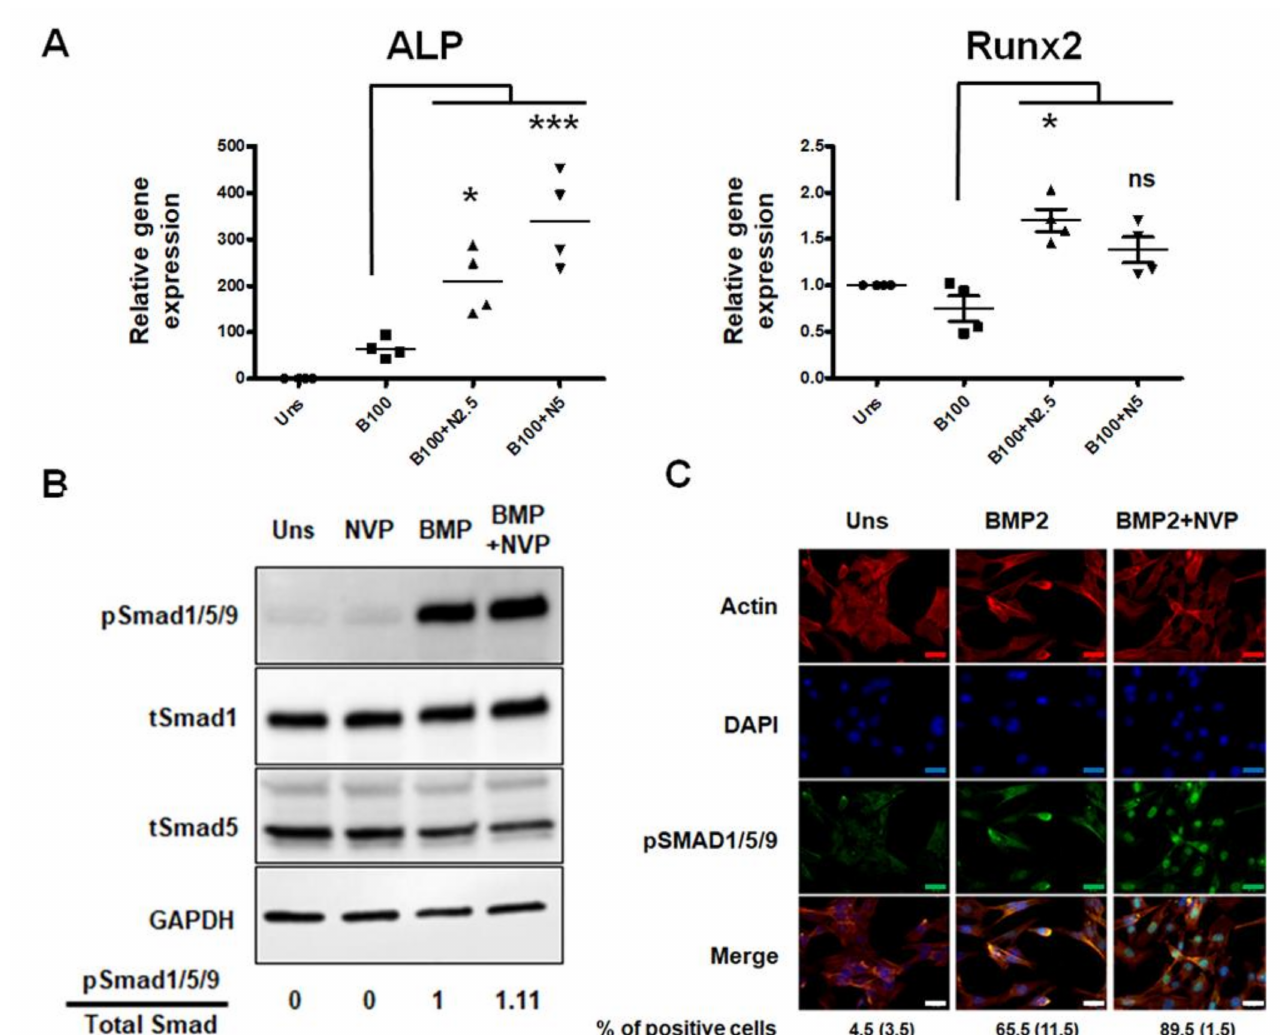
Figure 3. Effect of NVP on BMP2-induced osteoblast differentiation and Smad signaling. ( A ) C2C12 cells were stimulated for 48 h with BMP2 (100 ng/mL), or BMP2 and 2.5 mM or 5 mM NVP (B100+N2.5 or B100+N5). Total RNA was extracted and relative gene expression of ALP and Runx2 were analyzed by real-time PCR, normalized to Rps18 and presented as the relative level to unstimulated cells (Uns). ( B ) C2C12 cells were treated with NVP (5 mM), BMP2 (100 ng/mL) or BMP2+NVP for 30 min. Cells were lysed and total proteins were subjected to SDS-PAGE and blotted onto PVDF membrane. Phospho-Smad1/5/9 and total Smad1 were immunodetected usding specific rabbit polyclonal antibodies. GAPDH was used as a sample loading control. ( C ) C2C12 cells were grown on 15 µ -Chamber 12 well (Ibidi, Martinsried, Germany), stimulated with BMP2 (100 ng/mL) or BMP2 after 5 mM NVP pre-treatment (BMP2+NVP). After 30 min stimulation, cells were fixed and the nuclear translocation of phosphorylated Smad1/5/9 was shown by immunofluorescence staining. Error bar indicates S.D. from triplicate samples. *: p < 0.05; ***: p < 0.001. Scale bar: 25 µ